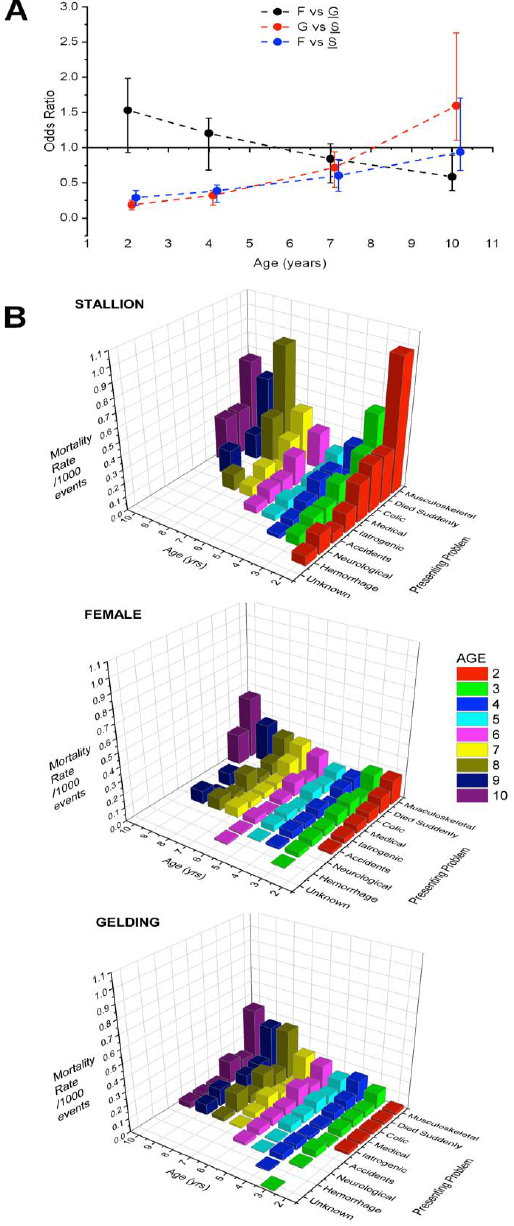
Figure 2. Mortality data from the Ontario Death Registry for work-events involving standardbred horses racing in the Province of Ontario in the period 2003–2015. Mortality by AGE (years) and SEX and describing a significant interaction identified through logistic regression analysis (outcome— binary response Registry membership, unit of interest—work-event). ( A ) Odds ratios for mortality and their 95% confidence intervals for the mean, comparing SEX and AGE group pairs. Referent SEX for each comparison is underlined in the figure legend. Thus, geldings have lower mortality rate than stallions at all ages except 10 years. F: female; G: gelding; S: stallion. Population-all work-events ( n = 1,778,330). Data points are offset horizontally for clarity. ( B ) Mortality rates/1000 work-events stratified by SEX, AGE, and presenting problem. Data show raw rates without adjustment for the influence of other factors. Results for AGE > 10 years are not presented because group sizes were small and rates erratic. The problem “unknown” reflects a single horse for which no data were available. Table S4 shows data for this